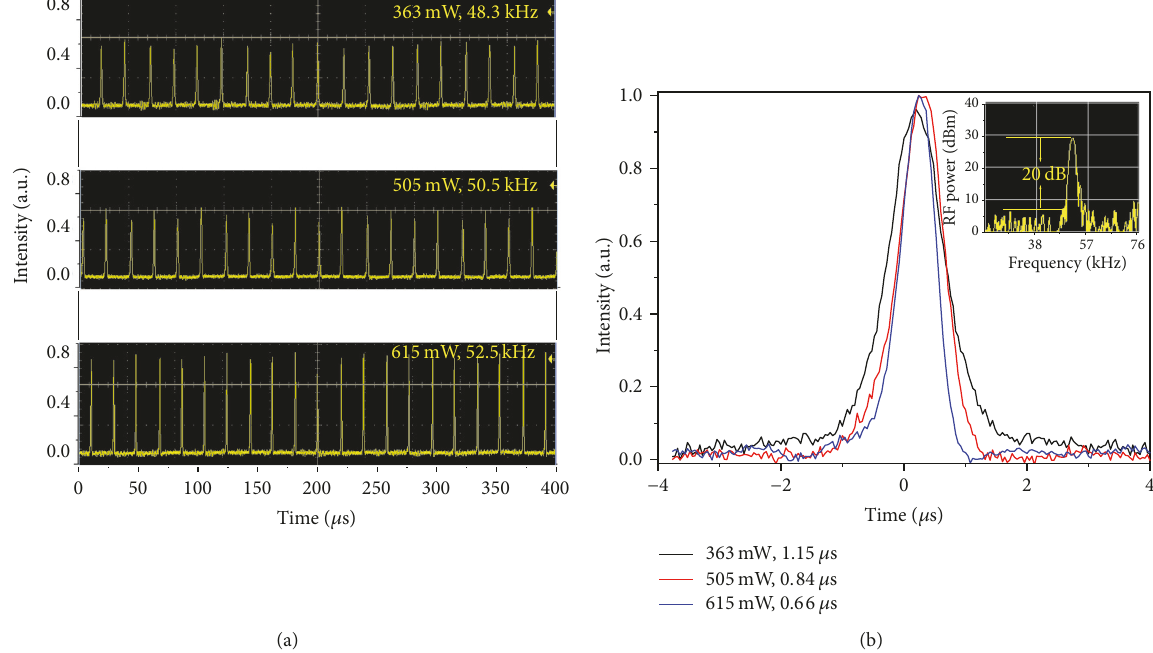
Figure 4: (a) Typical pulse trains at the average output power of 363 mW, 505 mW, and 615mW, respectively. (b) Corresponding pulse profiles. Inset: RF spectrum recorded at the average output power of 615mW.